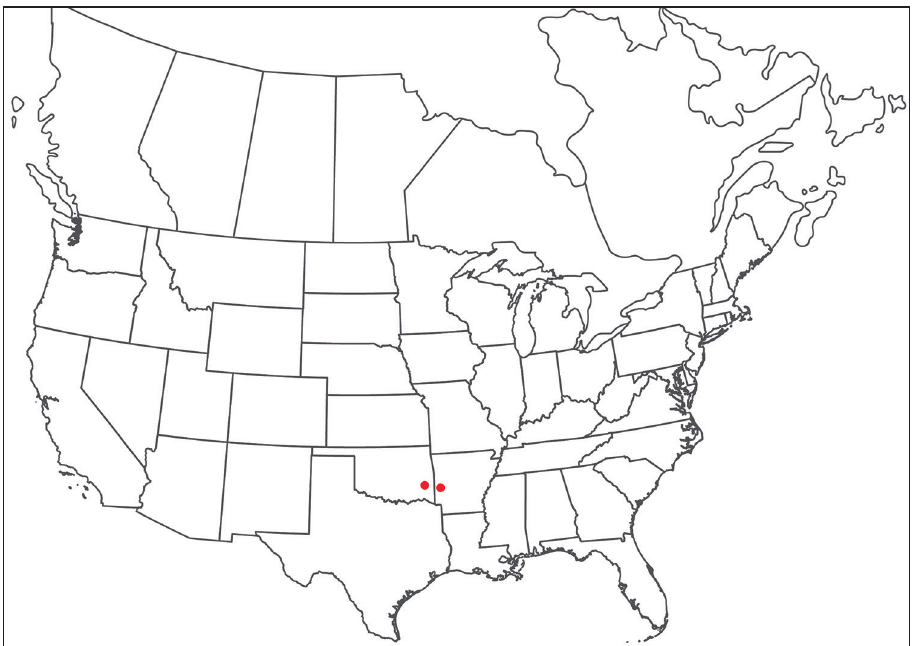
Figure 223. Torrenticola robisoni sp. n.